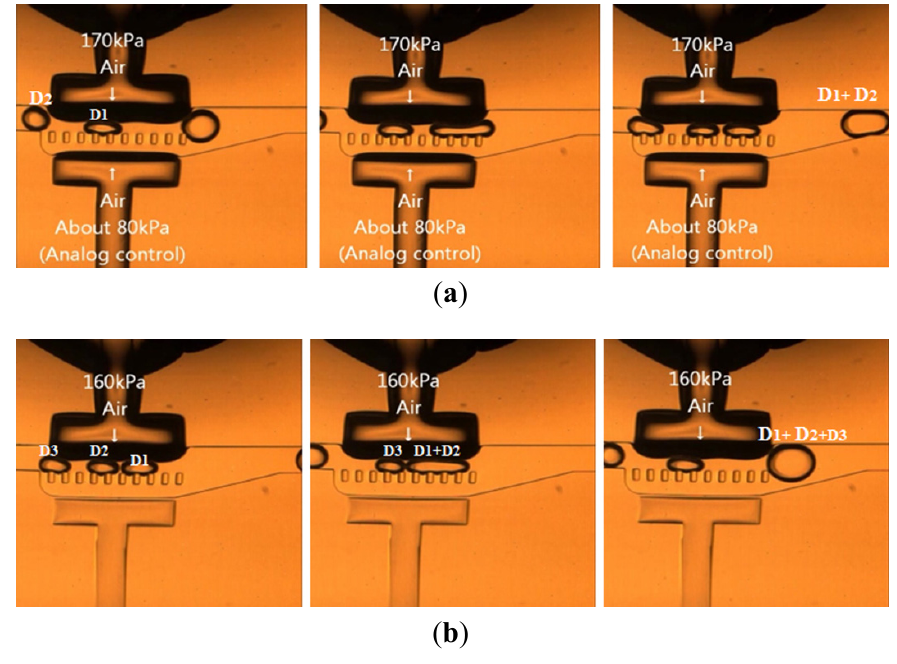
Figure 6. Different sizes and number of droplets merging. ( a ) Two Small Droplets Merging [(water) = 0.1 μ L/min, Carrier (oil) = 0.5 µL/min]; ( b ) Three Small Droplets Merging [(water) = 0.1 μ L/min, Carrier (oil) = 0.5 µL/min]; ( c ) Two Medium Droplets Merging [(water) = 0.5 μ L/min, Carrier (oil) = 0.5 μ L/min]; ( d ) Three Medium Droplets Merging [(water) = 0.5 μ L/min, Carrier (oil) = 0.5 μ L/min]; ( e ) Two large Droplets Merging [(water) =0.8 μ L/min, Carrier (oil) =0.3 μ L/min]; ( f ) Three Large Droplets Merging [(water) = 0.8 μ L/min, Carrier (oil) = 0.3 μ